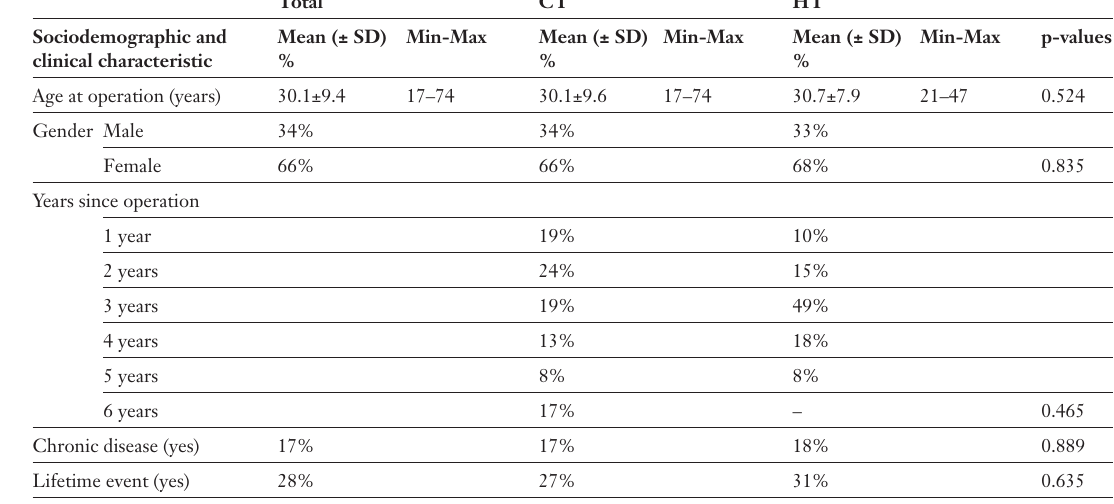
GBI Total Score and Subscales for hot and cold tonsillectomy (* Scores range from –100 to 100, where –100 means negative change and 100 means positive change in health status since opera-